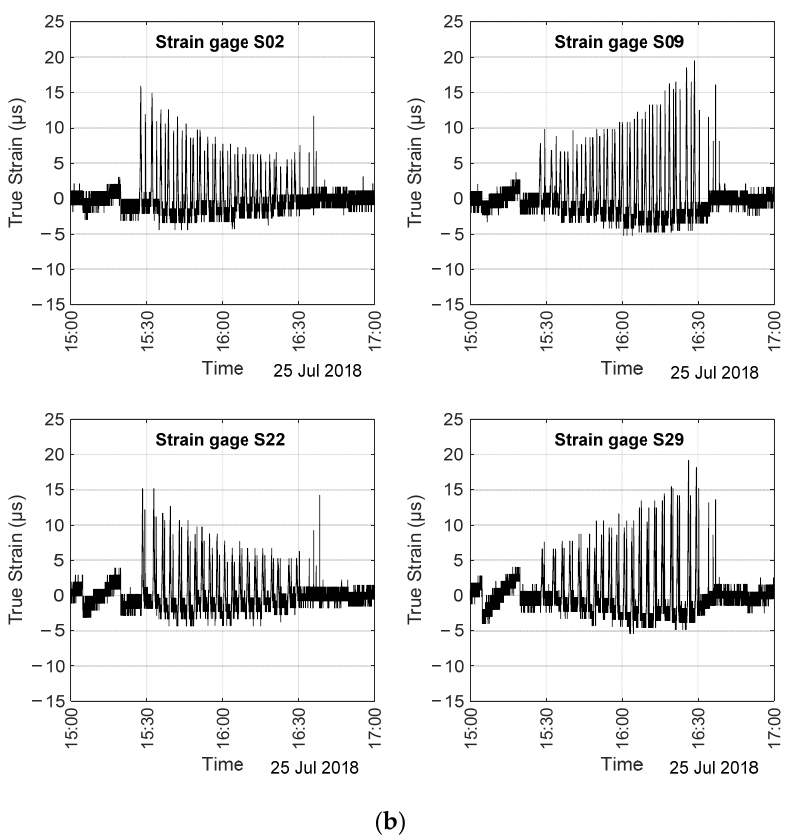
Figure 7. ( a ) Raw strain recorded during the truck load test; ( b ) true strain recorded during the truck load test.